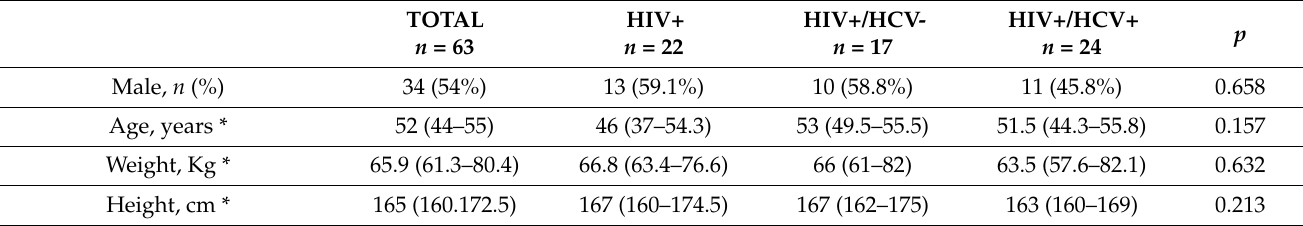
Table 1. Epidemiological characteristics of the study